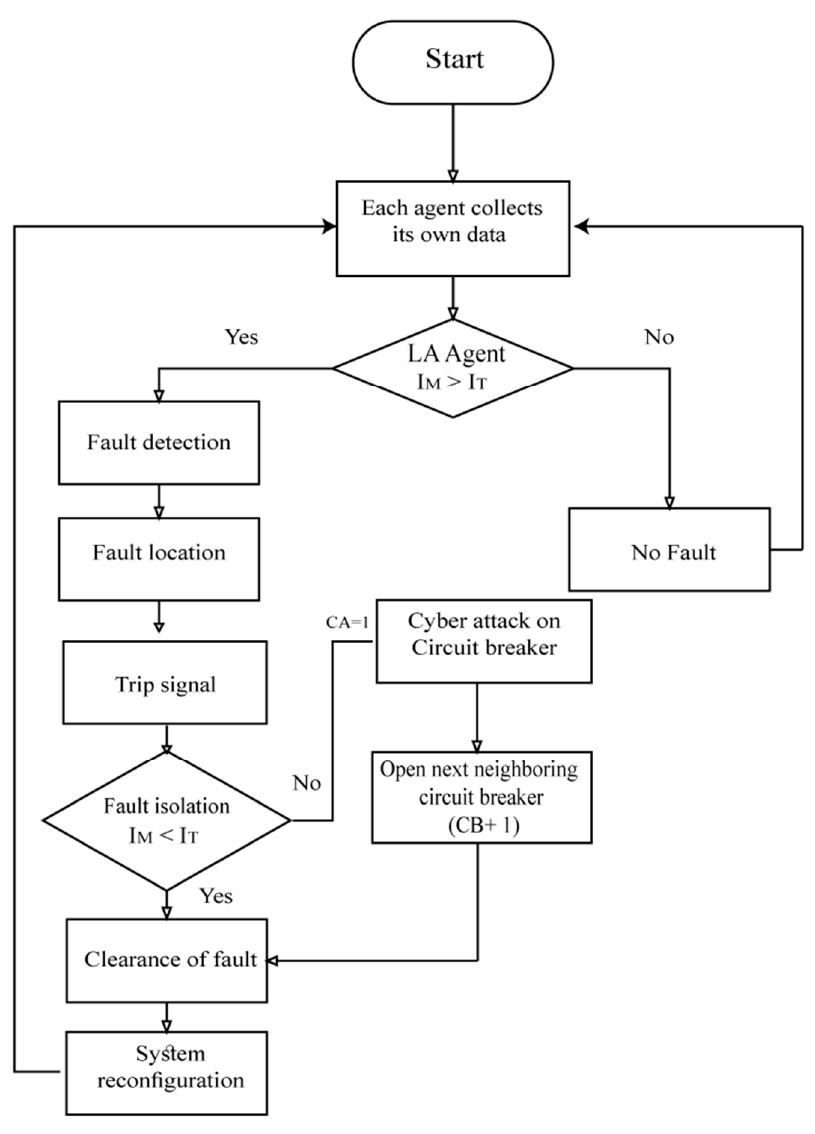
Figure 4. Flow diagram of the proposed protection scheme.